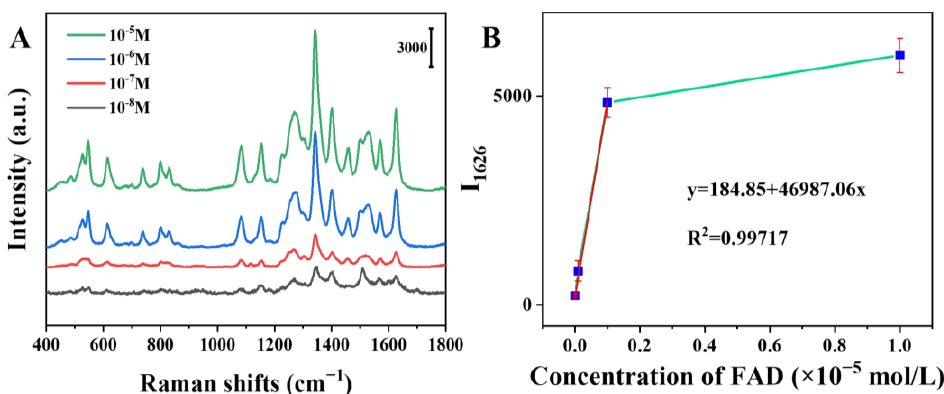
Figure 8. ( A ) The 532-nanometer-laser Raman spectra of 10 −5 , 10 −6 , 10 −7 , and 10 −8 M FAD on Ag nan- ofilms; ( B ) standard curve of intensity of 1626 cm −1 for the concentration of FAD. The regression nanofilms; ( B ) standard curve of intensity of 1626 cm − 1 for the concentration of FAD. The regression equation is y = 184.85 + 46987.06x, R 2 = 0.99717. equation is y = 184.85 + 46,987.06x, R 2 =